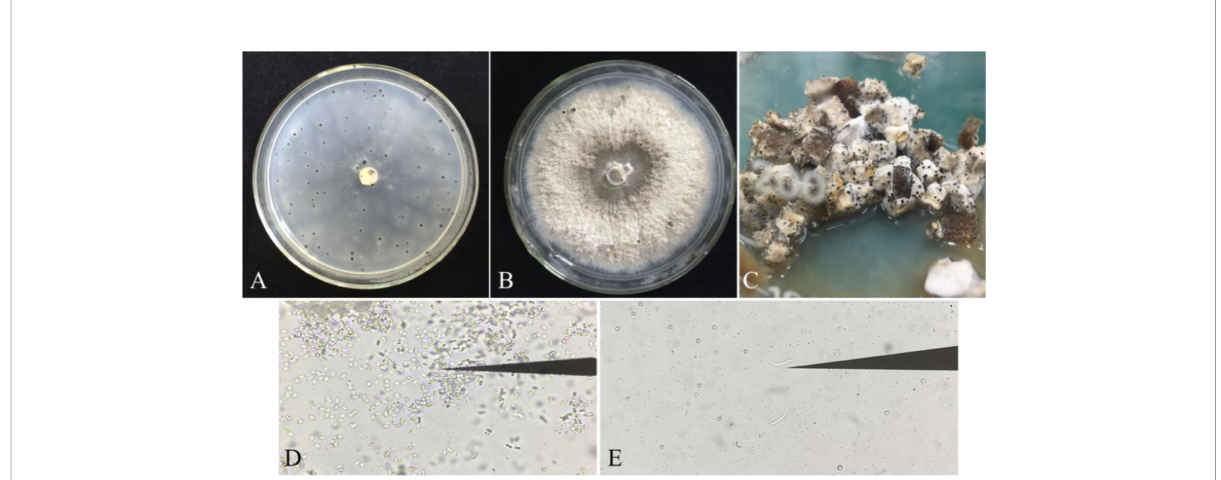
FIGURE 4 Pycnidia of P. vexans on different media. (A) Colony morphology of P. vexans Pycnidia on oatmeal agar medium after 30 days of incubation at 25°C. (B) Colony morphology of P. vexans Pycnidia on potato dextrose agar medium after 30 days of incubation at 25°C. (C) Colony morphology of P. vexans Pycnidia on S. melongena fruit medium after 5 days of incubation at 25°C. (D) a -type conidia under a compound microscope (400 X). (E) b -type conidia under a compound microscope (400